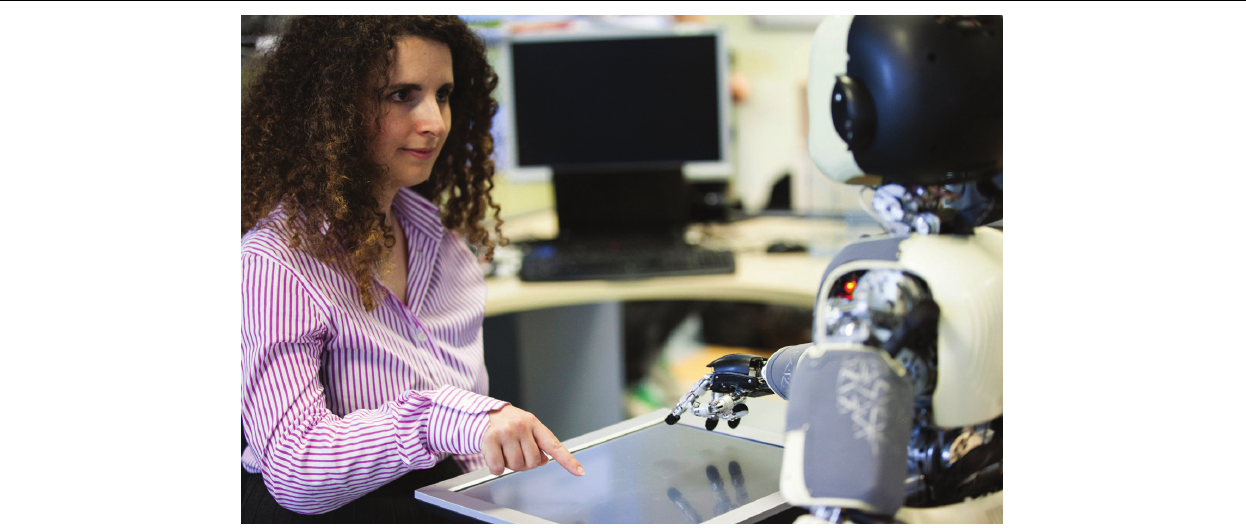
FIGURE 1 | An illustrative picture of human–robot interaction with the humanoid robot iCub. The mutual and spontaneous information exchange is mediated by context (i.e., the game on the touch screen that the two partners are playing) and by the agents’ gazing behavior, but also by the intention information embedded in their movement properties. Copyright photo: Agnese Abrusci, Istituto Italiano di Tecnologia©